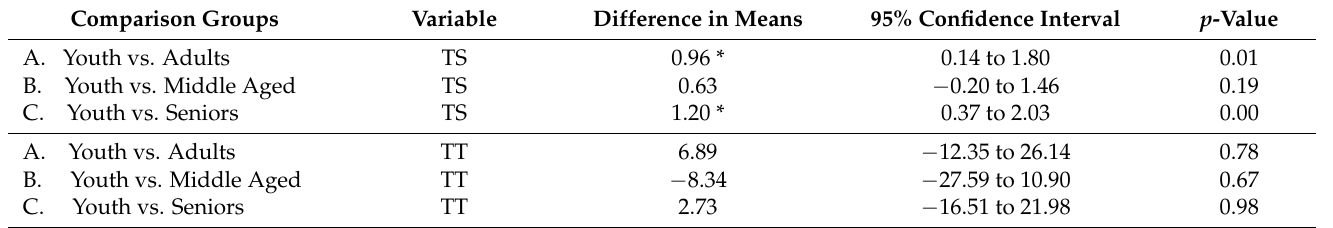
Table 2. Mean of comparison between groups (mean ± standard deviation).